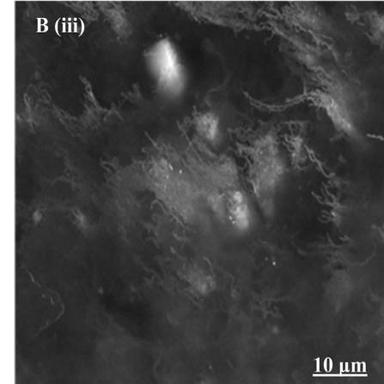
SEM images of 3% dispersion of paraffin wax and MWCNTs with various scale: B (i) treated MWCNTs with 1 µm, B (ii) treated MWCNTs with 4 µm, B (iii) treated MWCNTs with 10 µm.